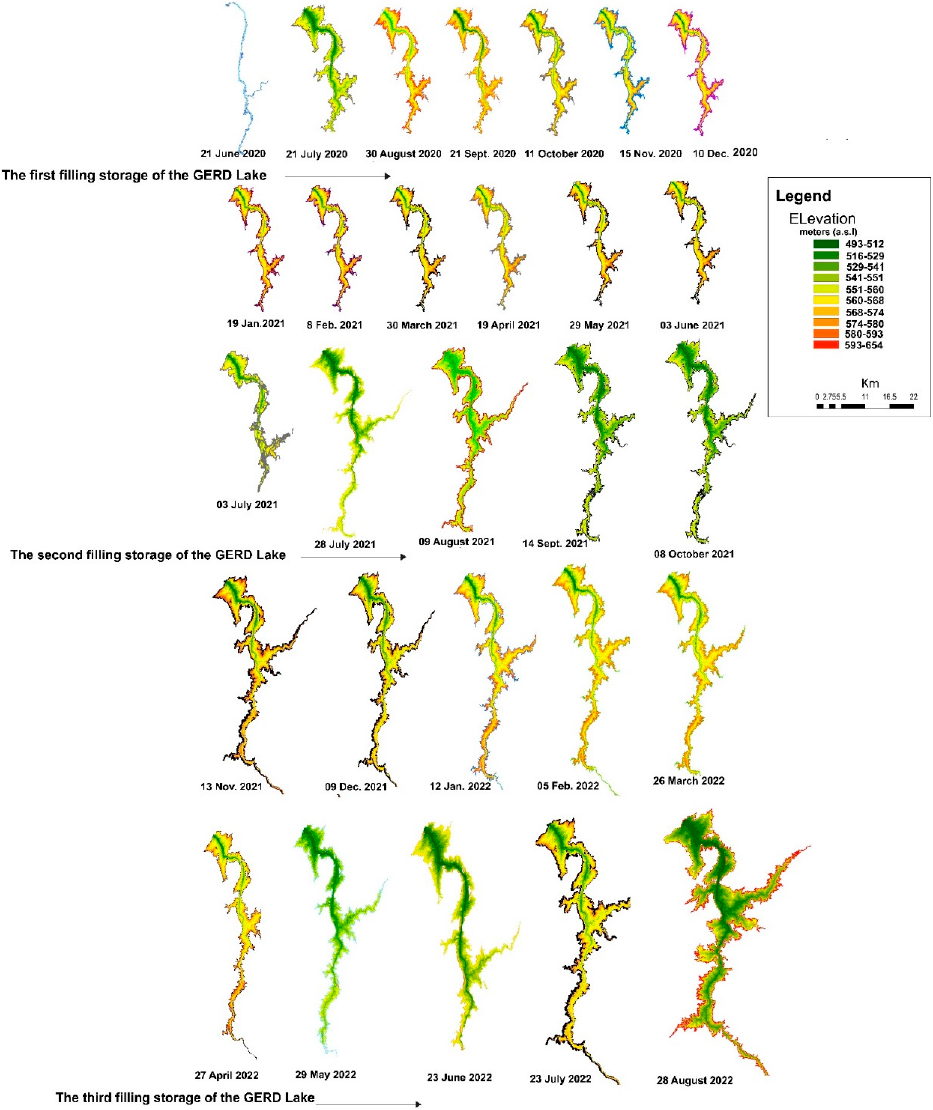
Figure 3. Digital elevation model (DEM) extracted by the GERD Lake polygons with time series from satellite images.